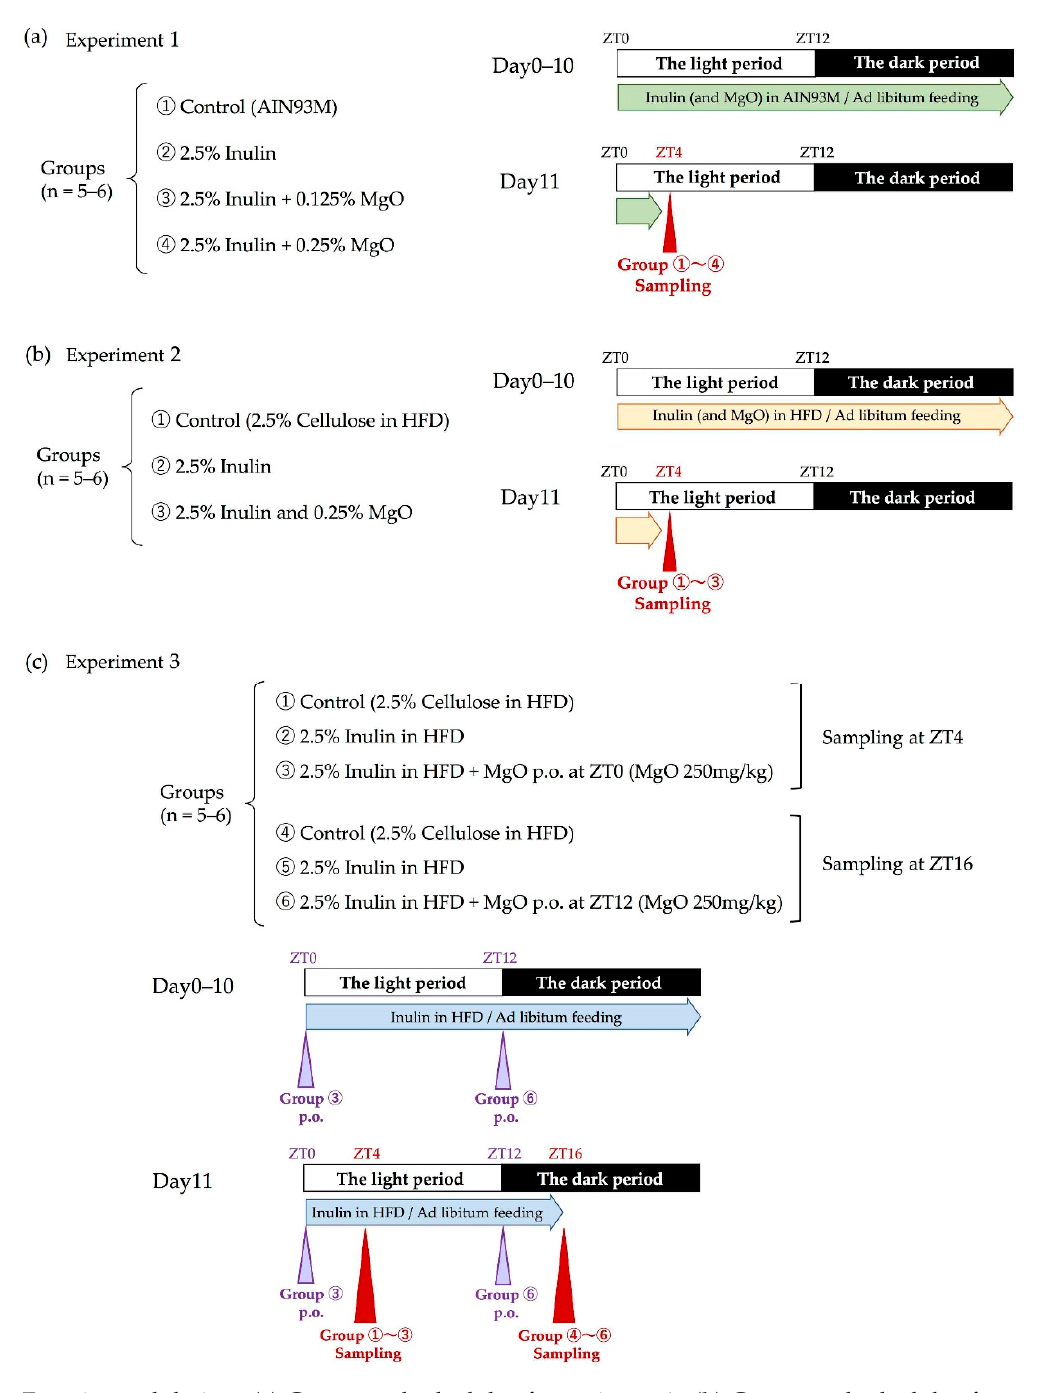
Figure 1. Experimental design. ( a ) Groups and schedule of experiment 1. ( b ) Groups and schedule of experiment 2. ( c ) Groups and schedule of experiment 3. White and black bars express a 12-h light/12-h dark cycle. ZT0 is lights-on time and ZT12 is lights-off time. Triangle arrows in red indicate sampling time. Triangle arrows in purple indicate oral administration time. Green, yellow or blue arrows indicate a period of ad libitum feeding. ZT: Zeitgeber time. MgO: magnesium oxide. HFD: high-fat